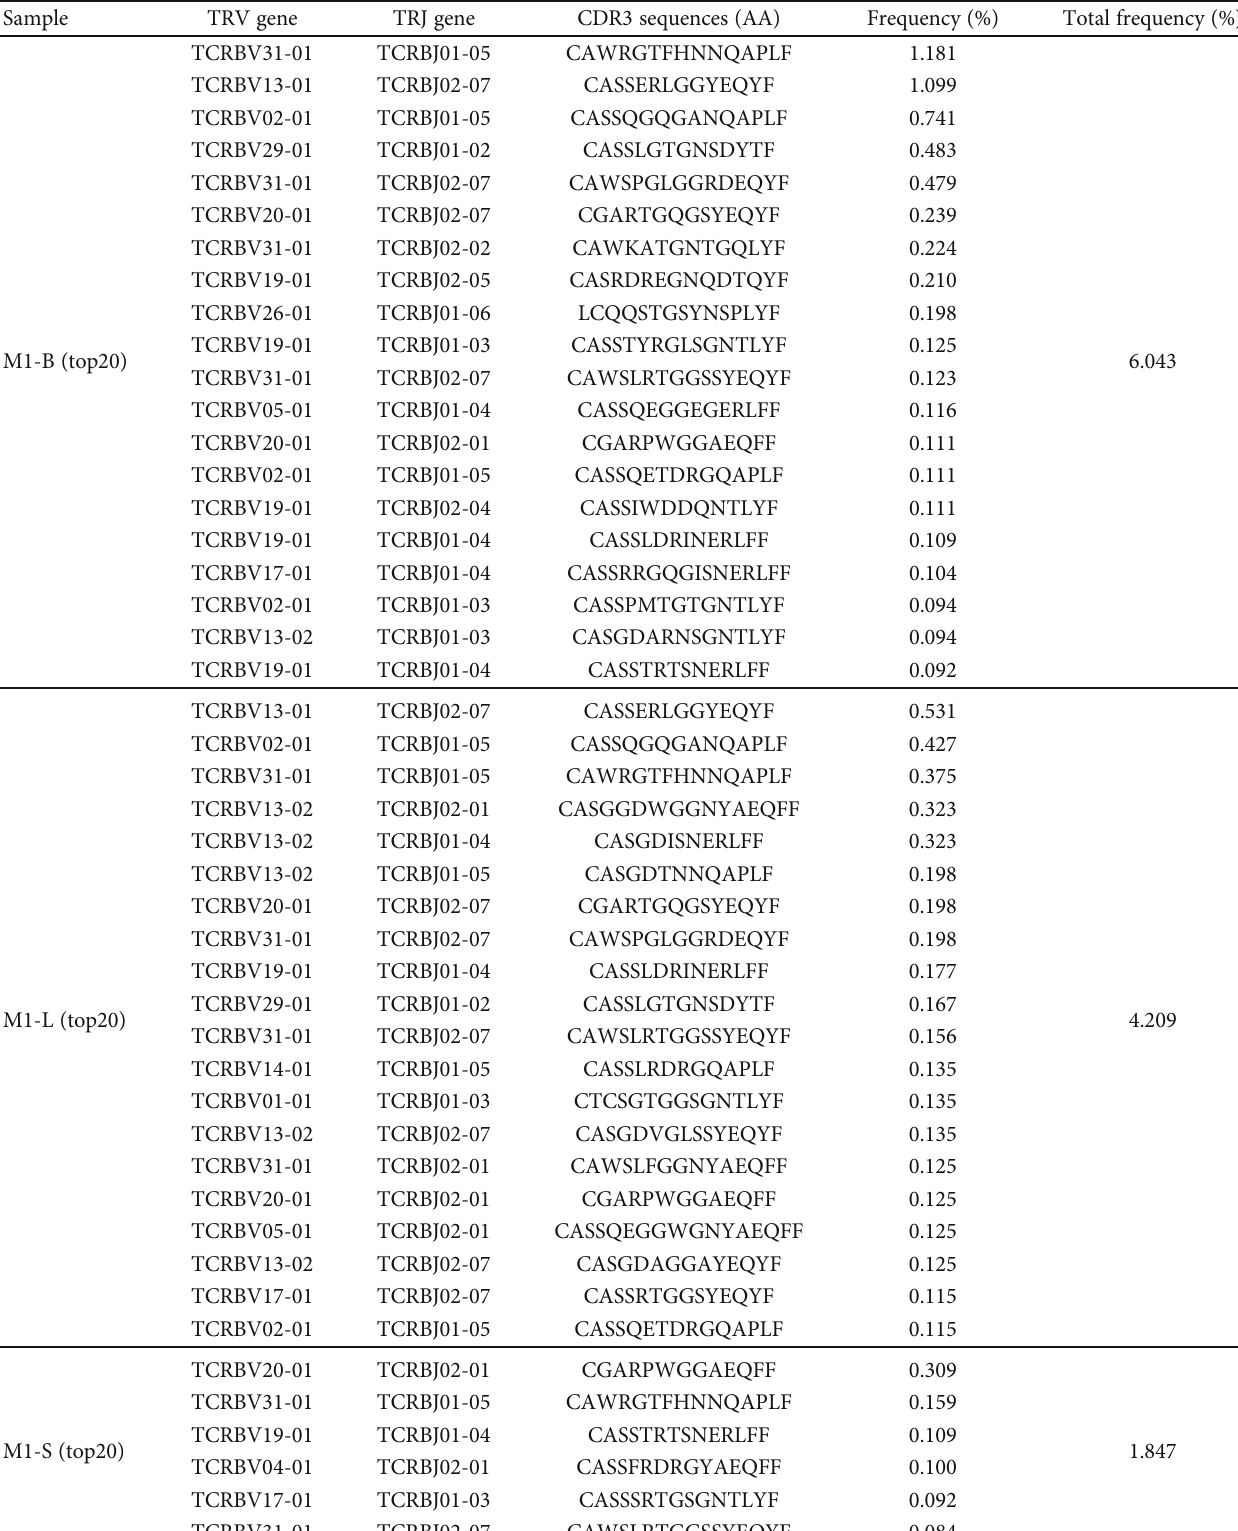
Table 8: Analysis of composition and characteristics of frequency for the top twenty sequences and the usage of TRBV and TRBJ gene, CDR3 AA of CD4 + CD25 + T cells TCR β CDR3 repertoires in breast tumor tissues, lung metastatic tissues, and spleens from 4T1 tumor-bearing BALB/c mouse